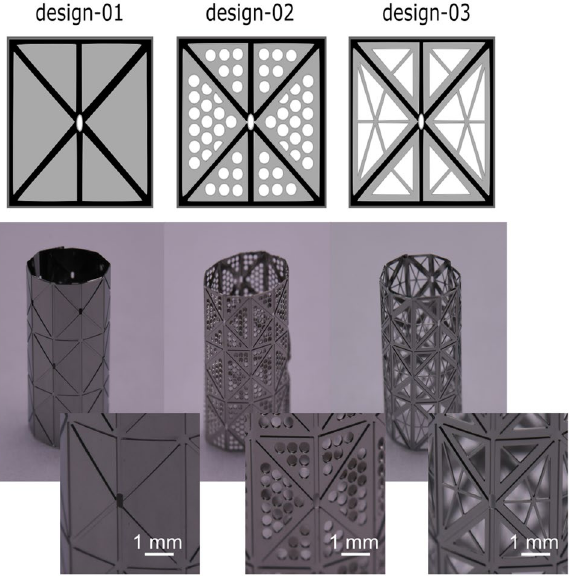
Figure 2. On the top, unit cell designs 01–03 are shown with varying porosities (Table S1), the hinges (black) are 5 µm thick, and the rigid regions (grey) are 40 µm thick. On the bottom, a profile photo showing the fabricated stents with four different geometries with a unit cell length of 3 mm. The inset shows the magnified view of each unit cell. The image is made using Inkscape (V 0.92, https:// inksc ape.